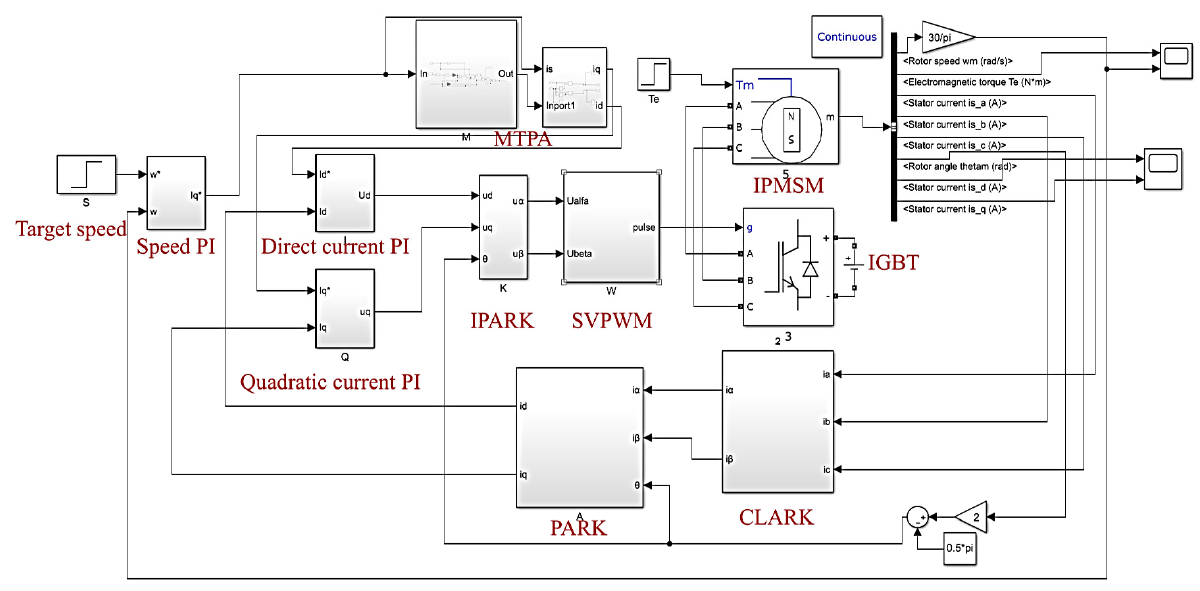
Figure 5. MRAA reference